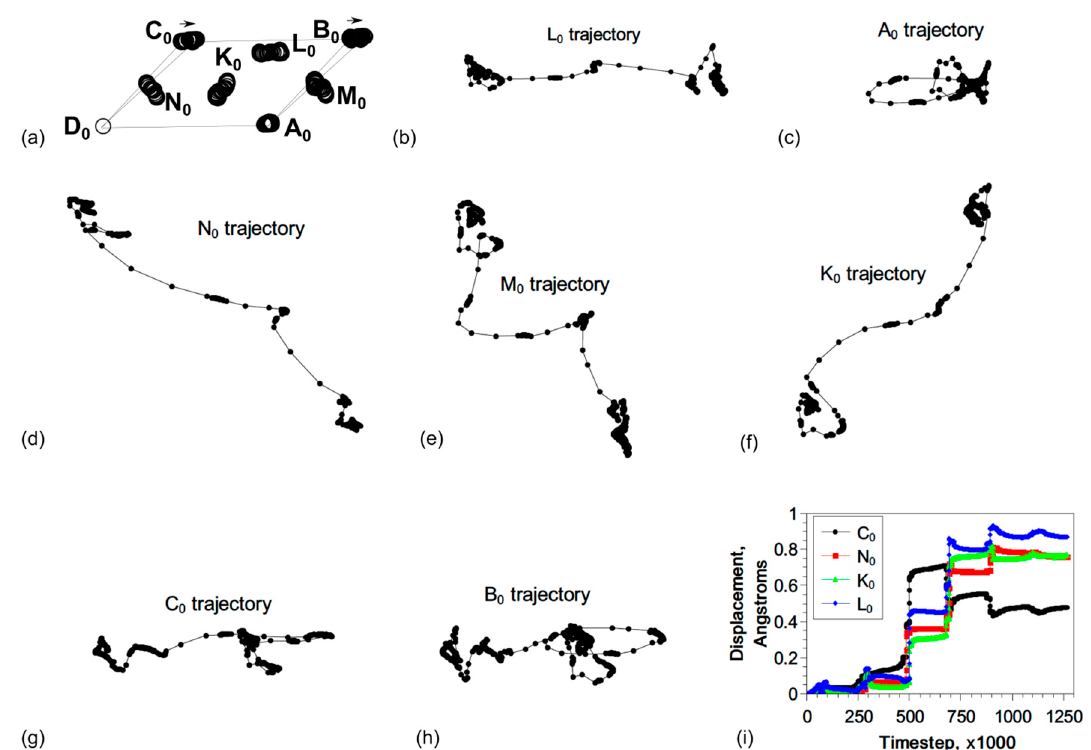
Figure 15. ( a ) General view of atomic motions during passage of disconnections through volume A 0 B 0 C 0 D 0 ; ( b ) Trajectory of atom L 0 ; ( c ) Trajectory of atom A 0 ; ( d ) Trajectory of atom N 0 ; ( e ) Trajectory of atom M 0 ; ( f ) Trajectory of atom K 0 ; ( g ) Trajectory of atom C 0 ; ( h ) Trajectory of atom B 0 ; ( i ) Dependence of displacement distance on timestep for selected atoms. Shear and shuffling take place simultaneously. Trajectories are shown, relative to the atom D 0 , which was taken as a reference.